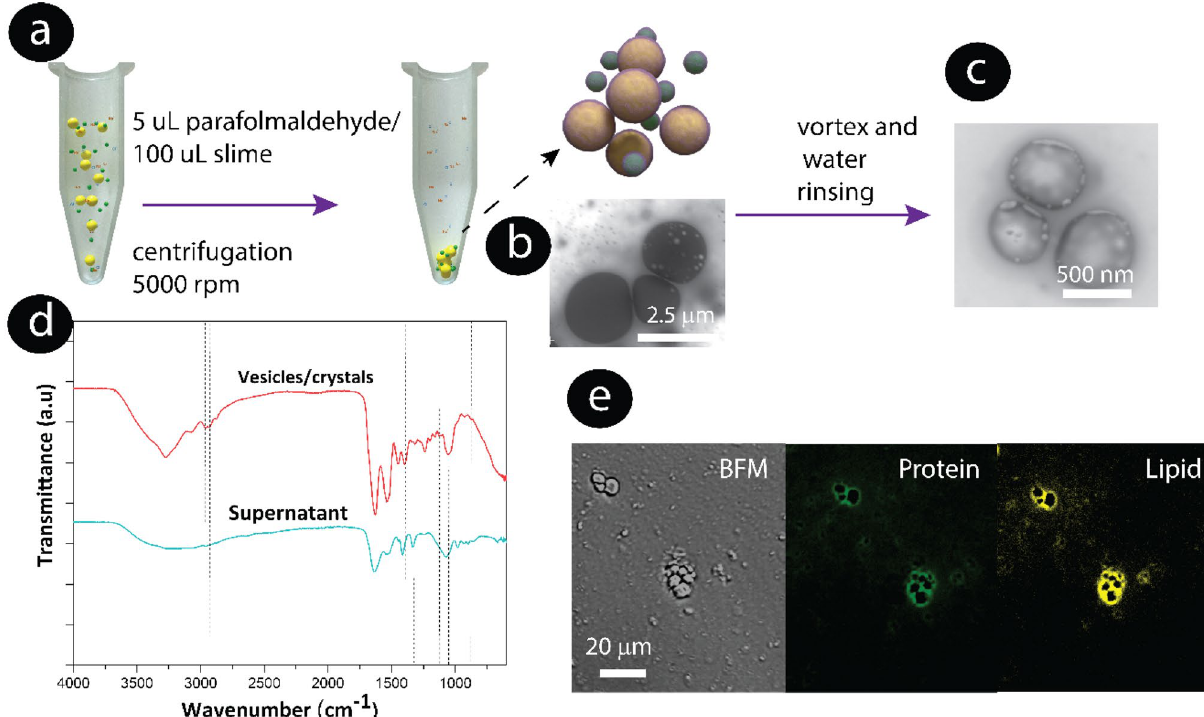
Figure 4. Particle and vesicle isolation process. ( a ) Scheme of the aldehyde fixation used to prevent the highly fragile carbonate and phosphate particles from reacting with each other. Centrifugation was used to collect the particle fraction of the slime. TEM image of ( b ) vesicles before rinsing and vortex. ( c ) Vesicles after rinsing with water and vortex. Note the morphology of the protein/lipid membrane left after rinsing the particles. ( d ) FTIR spectra of the pristine centrifuged pellet containing crystalline particles, protein fibers (e.g collagen), and supernatant. ( e ) Staining of particles isolated in the aqueous solution. BFM: Bright field image of particles isolated in the aqueous solution, focusing at the middle particle heigth, and after protein (green) and lipid (yellow). staining Note that the protein and lipid fluorescence signal exclusively highlights the outer layer and that the particle centers are